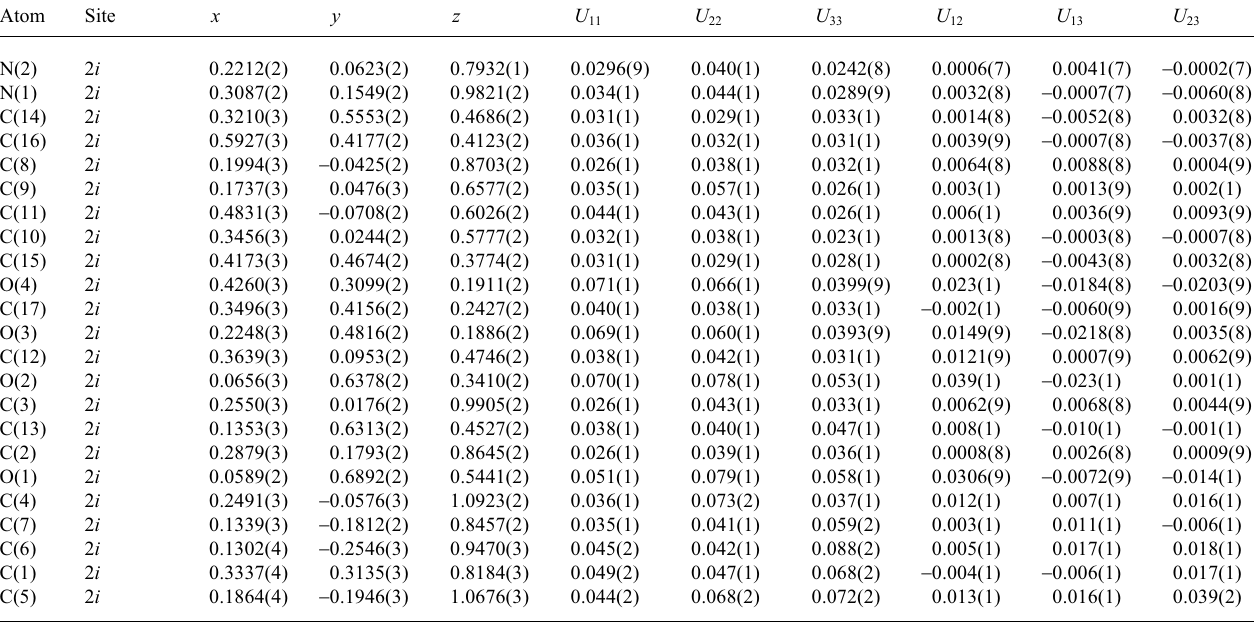
Table 3. Atomic coordinates and displacement parameters (in Å 2 )